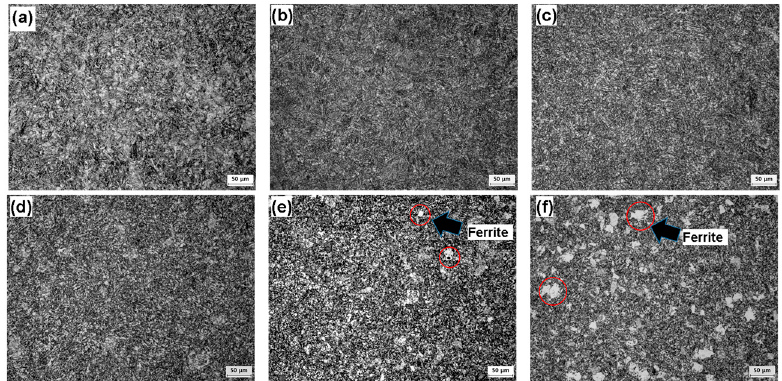
Figure 11. Optical microscopy (OM) images showing the morphology of advanced alloy at cooling rates of ( a ) 300 °C/min, ( b ) 100 °C/min, ( c ) 50 °C/min, ( d ) 20 °C/min, ( e ) 15 °C/min, and ( f ) 10 °C/min.